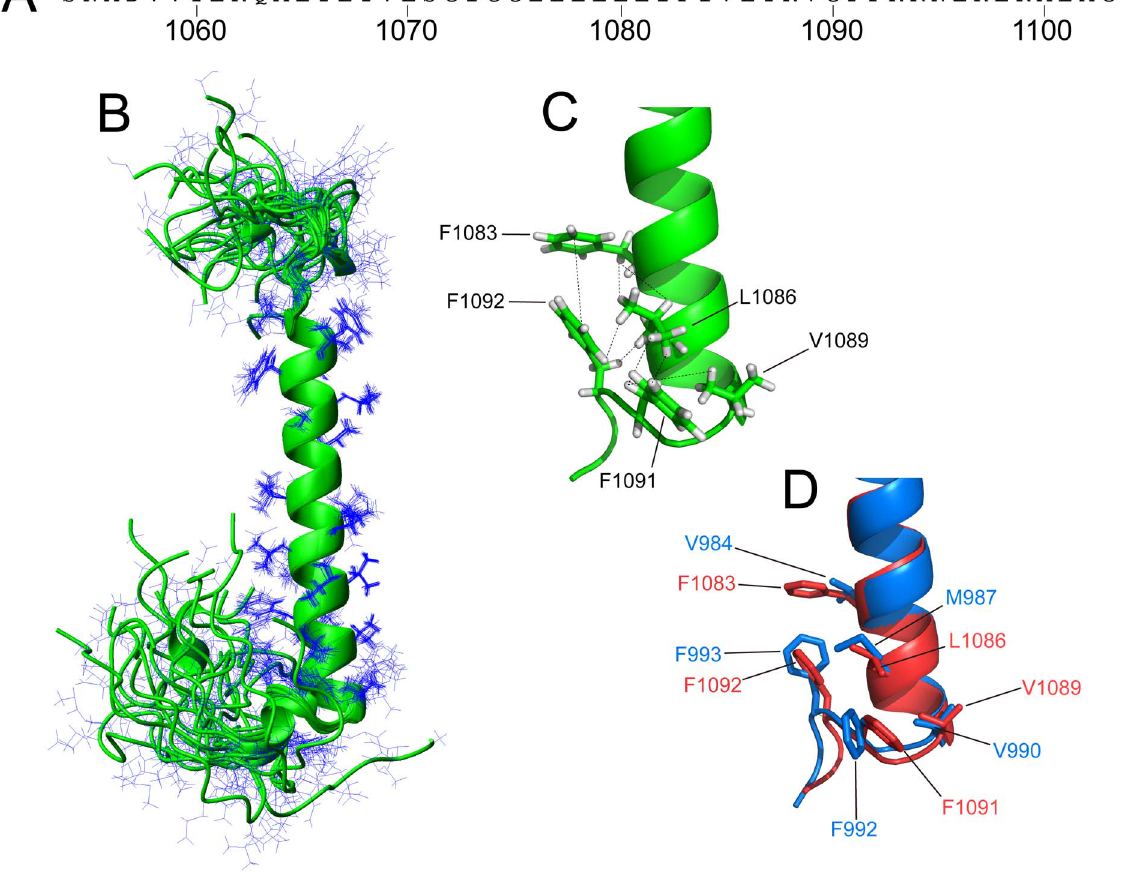
Figure 1. Structure of the integrin a LTM domain. (A) Sequence of the a L TM peptide used in this work with a L chain-context numbering; (B) superposition of an ensemble of 20 calculated simulated annealing structures of a L-TM; side-chains are shown as line representation; (C) a L close up of the IMC region with main residues involved in the formation of the reverse turn. For illustration, some NOEs found are represented as broken lines; (D) structural alignment of a L-TM (Leu-1078 to Arg-1094, in red), and a IIb-TM (PDB code: 2K1A, Leu-979 to Arg-995, in blue). The side-chains are shown as line representation and hydrogen atoms are omitted for simplicity.